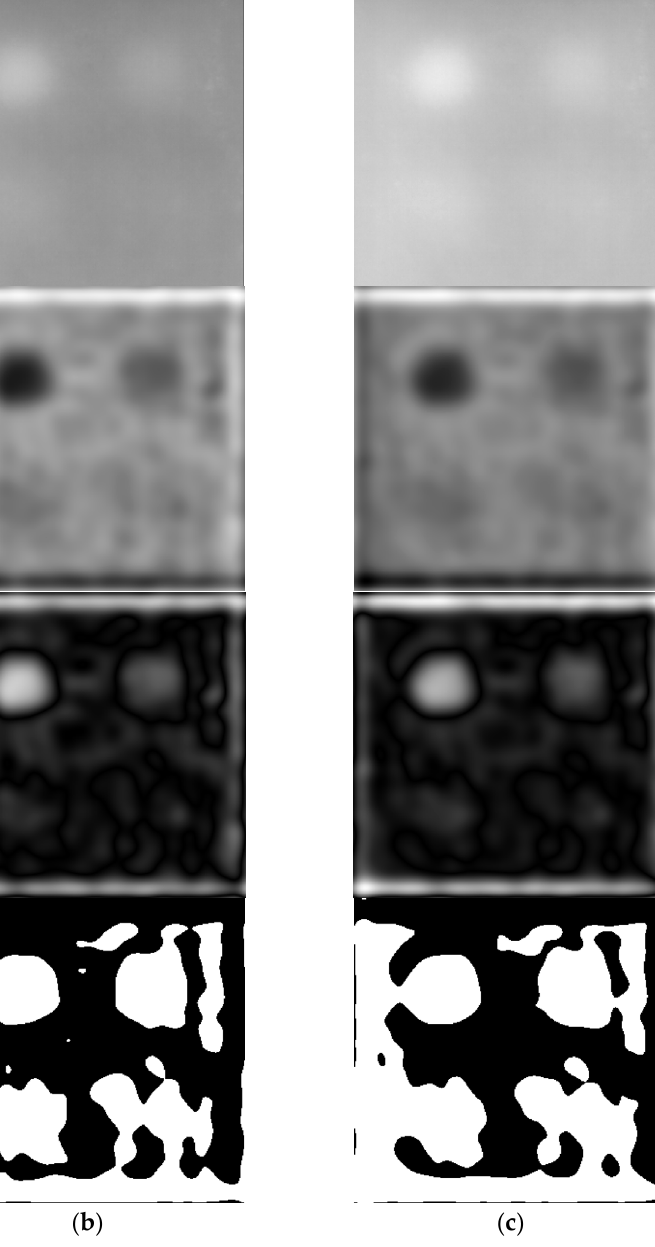
Figure 15. The continuous wavelet transformation results after processing the thermal (grayscale) images, at a scale factor of a = 10. The input images were captured during the heating stage at the end of ( a ) 30 min, ( b ) 60 min, and ( c ) 120 min.